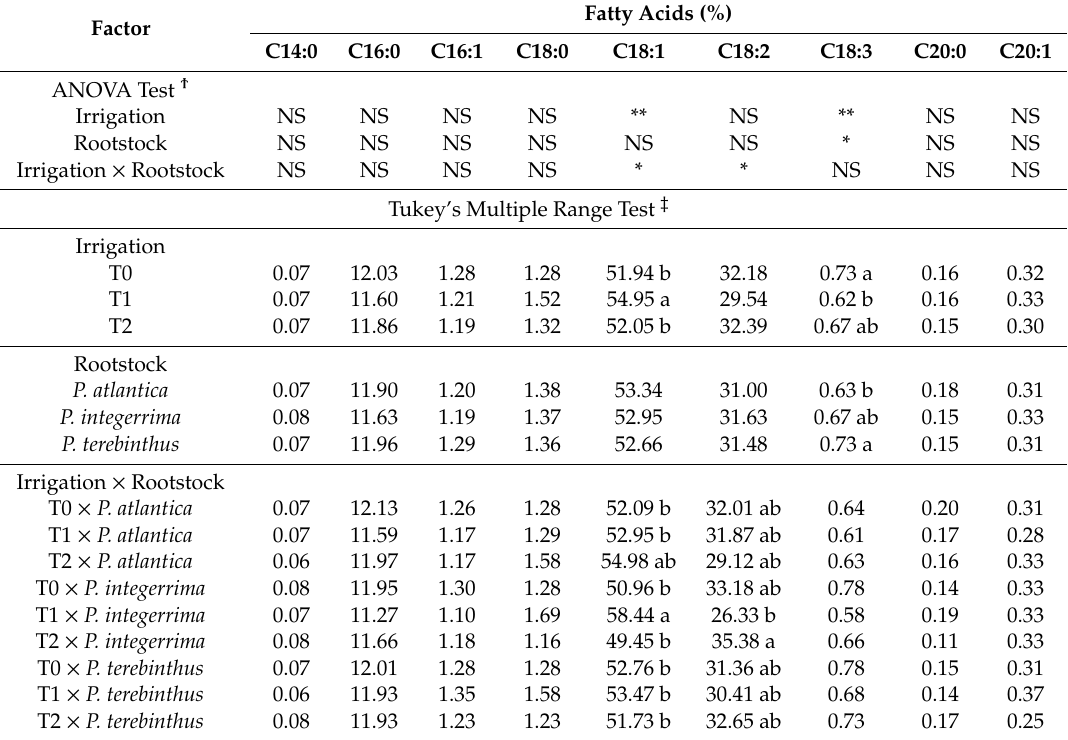
Table 5. Fatty acid composition of pistachios as a ff ected by deficit irrigation treatment and rootstock.